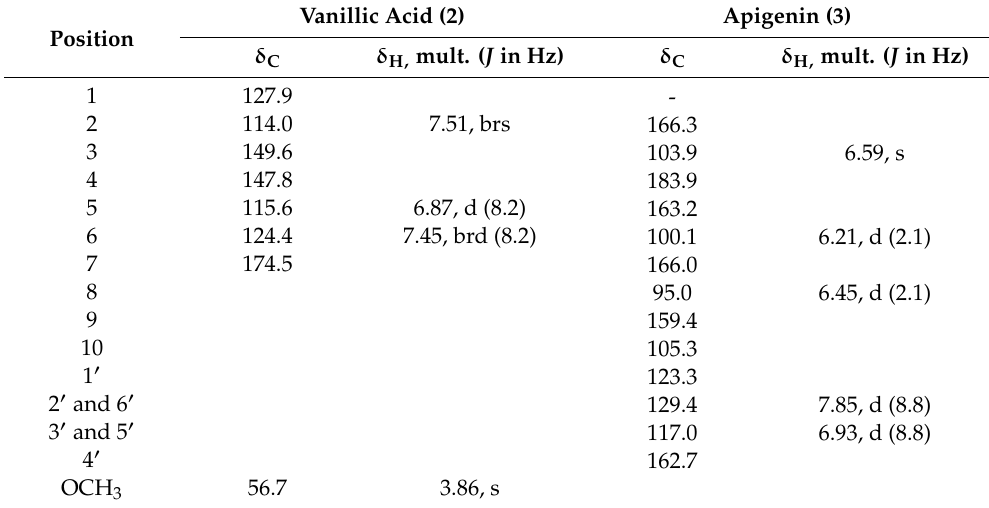
Table 2. 1 H and 13 C-NMR spectroscopic data of compounds 2 and 3 in CD 3